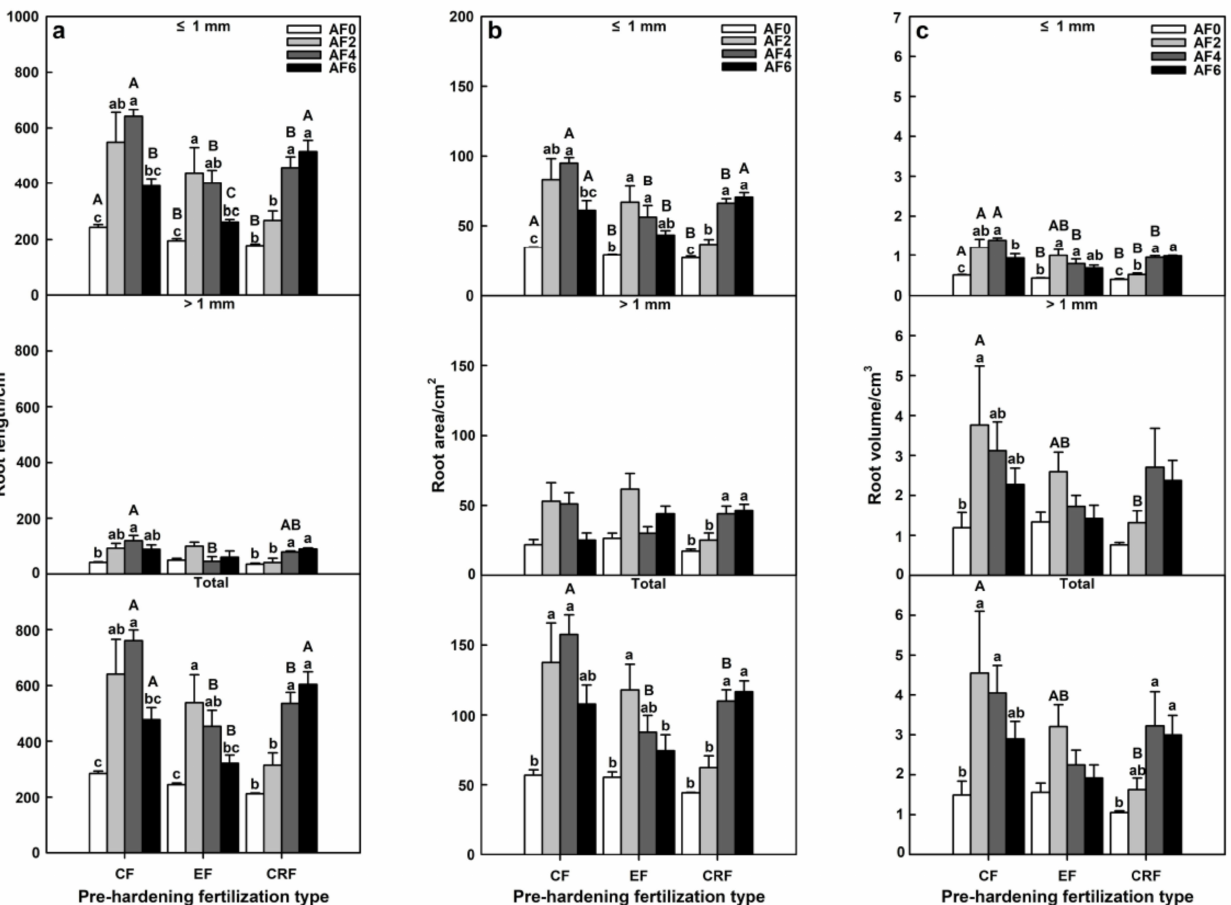
Figure 2. Root length ( a ), area ( b ), and volume ( c ) in seedlings of Pinus koraiensis in response to pre-hardening fertilization type (CF, EF, and CRF) and autumn fertilization level (AF0, AF2, AF4, and AF6) treatments. Bars and arrows represent the mean and corresponding standard error, respectively. Different capital letters indicate a significant effect of root traits among pre-hardening